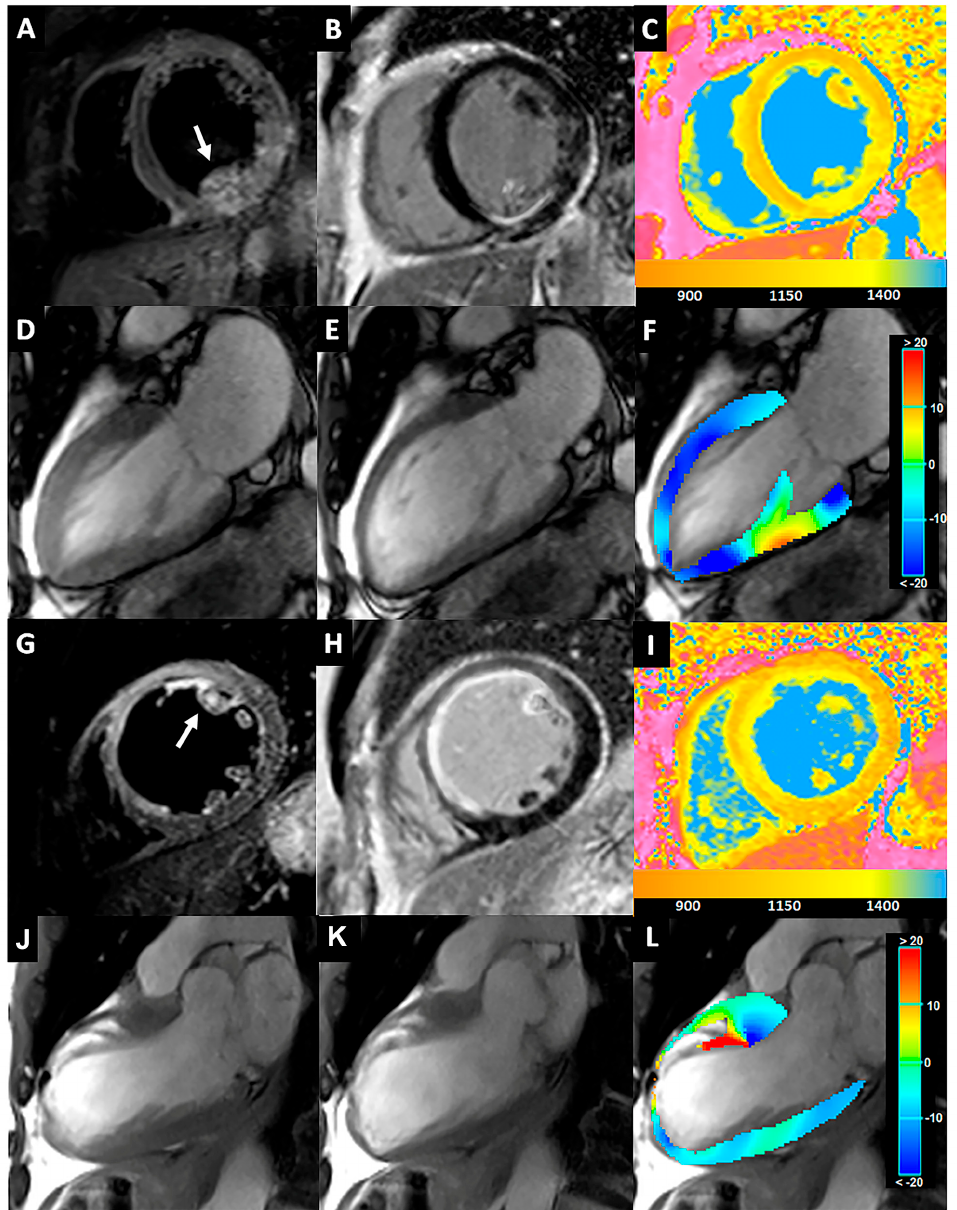
Figure 5. (A– F ) A 55-year-old man with inferior STEMI for RCA occlusion. T2-STIR ( A ) and LGE ( B ) images acquired on the short-axis views revealed LV inferior wall edema and enhancement, respectively, with PM-PPM involvement ( arrow ). In the corresponding nT1 map ( C ), PM-PPM showed a similar increase in the nT1 values compared to the infarcted myocardium (yellow color). The CineMR images acquired on the long-axis view in the end-diastolic ( D ) and end-systolic ( E ) phases showed hypokinesia of the lower wall and impaired contraction (lower shortening and thickening) of PM-PPM, as shown in the colorimetric map of longitudinal strain analysis by the tissue tracking automatic module ( F ). ( G – L ) A 61-year-old with extensive anteroseptal STEMI due to LAD proximal occlusion. A large area of transmural myocardial edema and mid-wall/subendocardial enhancement of the anteroseptal LV wall are visible in the T2-STIR ( G ) and LGE images ( H ), respectively, with AL-PPM involvement (arrow). The nT1 map ( C ) demonstrated a strong increase in the infarcted area, included in the AL-PPM (yellow color). AL-PPM is akinetic on the cineMR images acquired on the long-axis view in the end-diastolic ( J ) and end-systolic ( K ) phases, as highlighted by a red color depicting the severely reduced PPM-ls ( L ). STEMI: ST-elevation myocardial infarction; RCA: right coronary artery; LGE: late gadolinium enhancement; LV: left ventricular; PM: posteromedial;